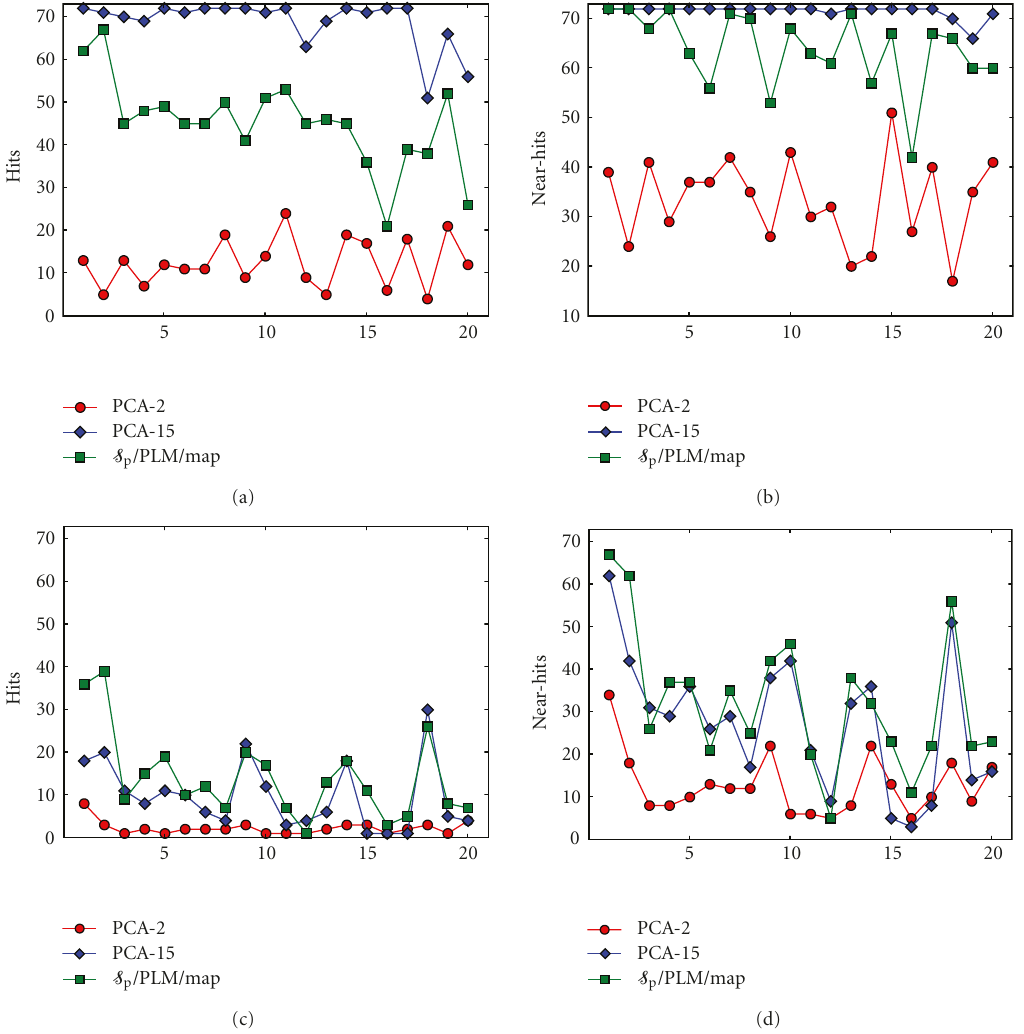
Figure 7: Projection of the sets of the COIL-20 database (abscissa represents the index of the data set, ranging from 1 to 20). The curves represent (a) hits with 0% occlusion, (b) near hits with 0% occlusion, (c) hits with 40% occlusion, (d) near hits with 40% occlusion for di ff erent paradigms (PCA and 2-dimensional S P ).